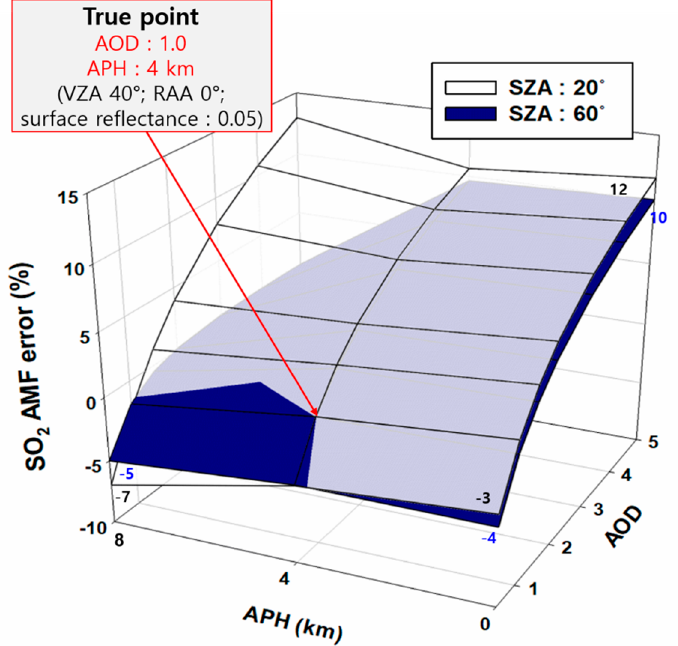
Figure 12. Percent difference in volcanic SO 2 AMF calculated with various AOD, APH, and SZA values compared with a ‘true’ AMF that is calculated for AOD = 1.0, APH = 4 km, and SZA = 20° and 60° (VZA = 40°; RAA = 0°; surface reflectance = 0.05; O 3 VCD = 275 DU; wavelength = 375 nm; aerosol type = volcanic aerosol).